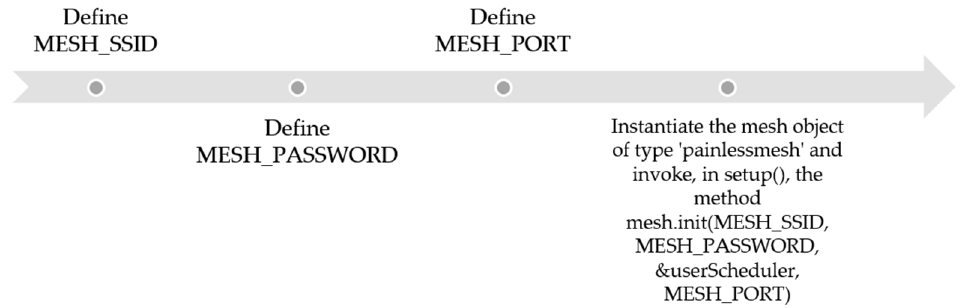
Figure 3. Initial setup process of a painlessMesh network.